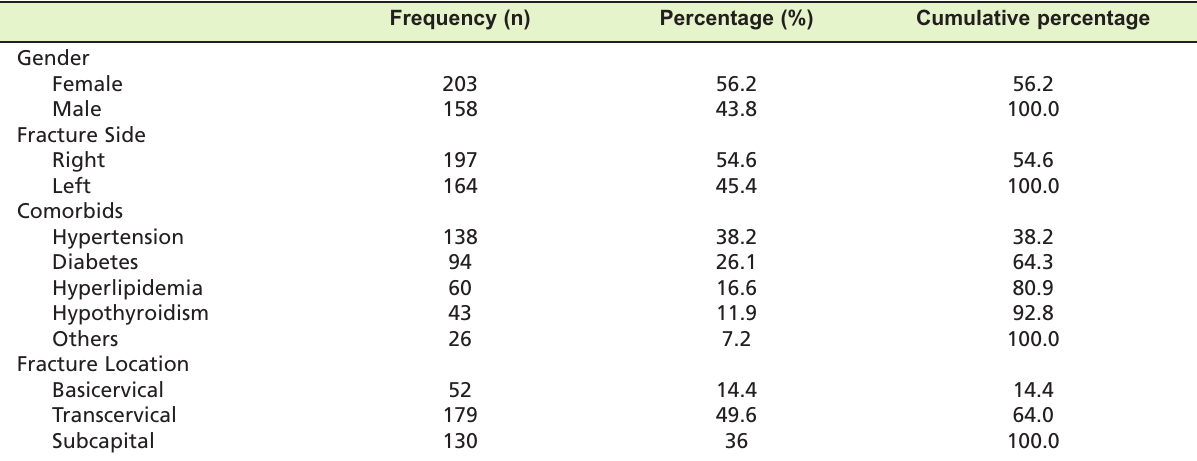
Demographic distribution of the patients Table II: